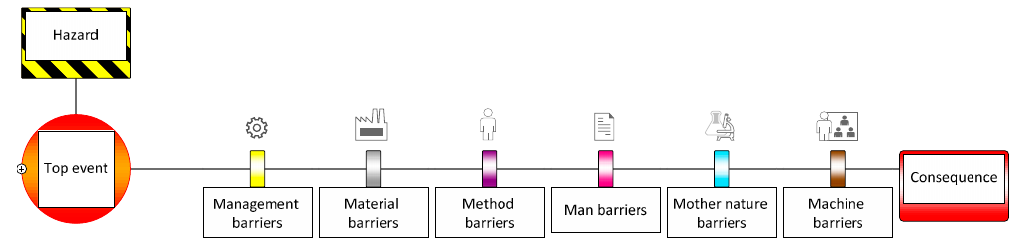
Figure 7. Threat path with coloured barrier categories.